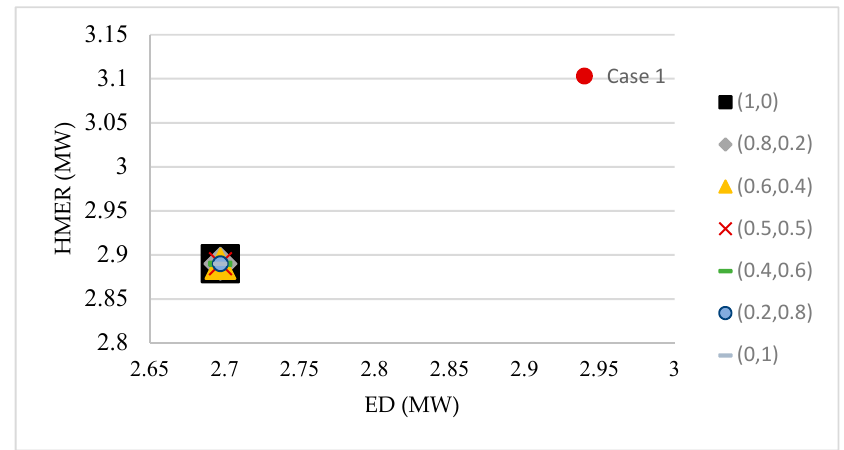
Figure 13. Optimal set of Pareto for the weighted bi-objective function including minimum energy requirements (MER) and exergy destructions function. Energies 2019 , 12 , x FOR PEER REVIEW